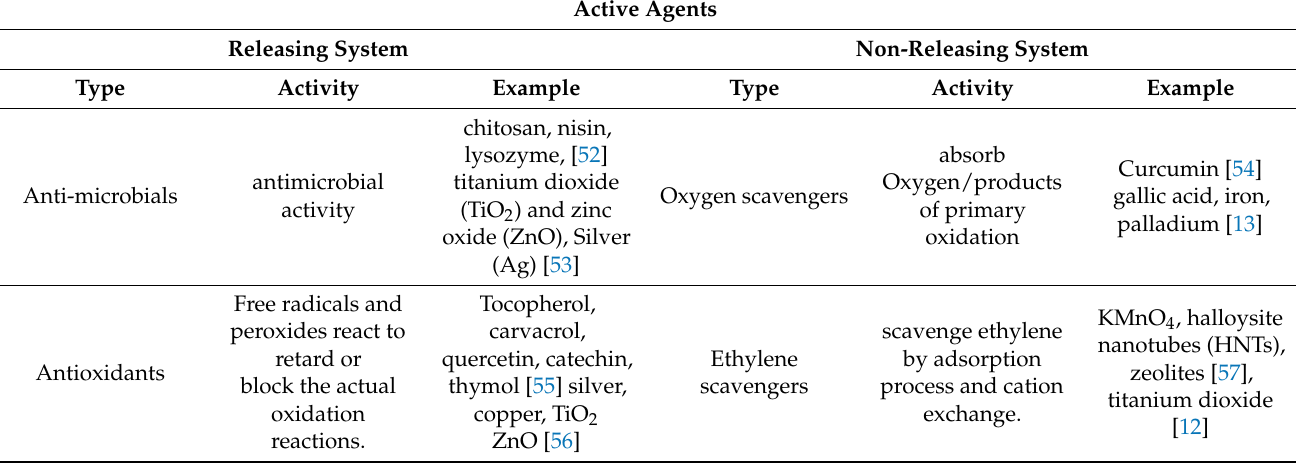
Table 1. Classification, mode of action and some examples of active